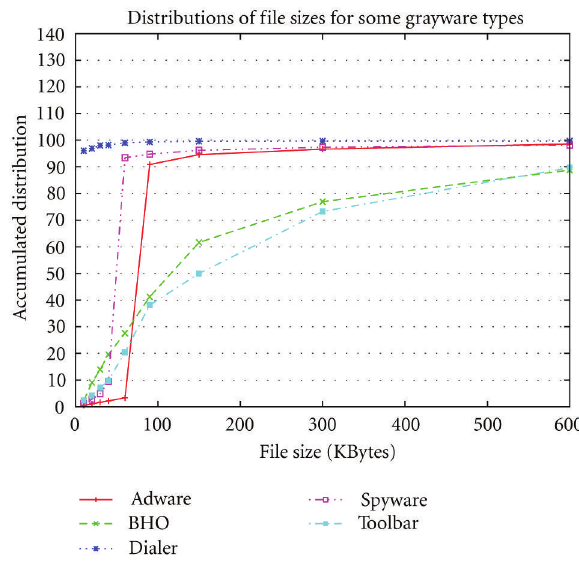
Figure 22: Accumulated grayware distribution on Grayware Type and File